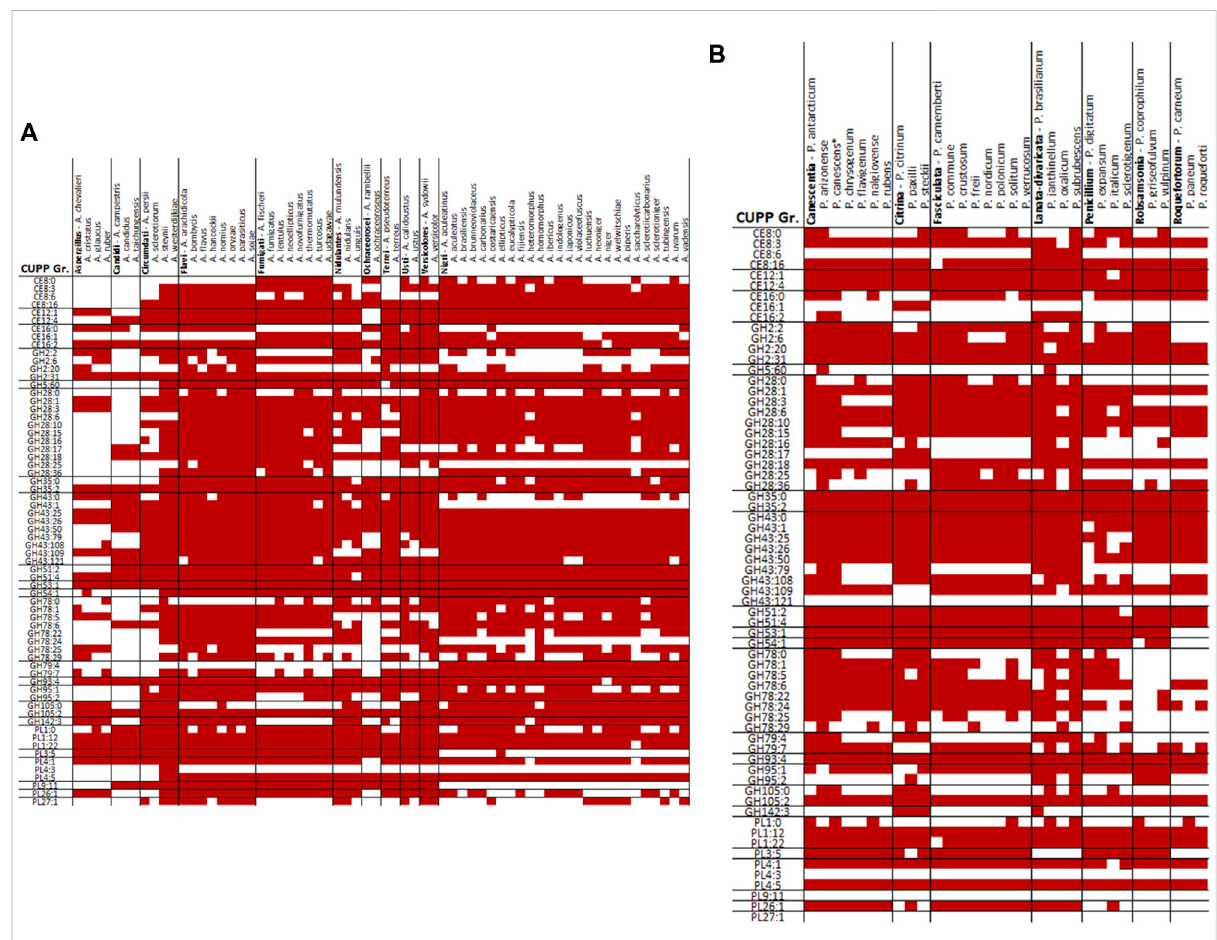
FIGURE 5 Overview of CUPP groups found in individual species of Aspergillus and Penicillium in red: (A) Aspergillus spp. and (B) Penicillium